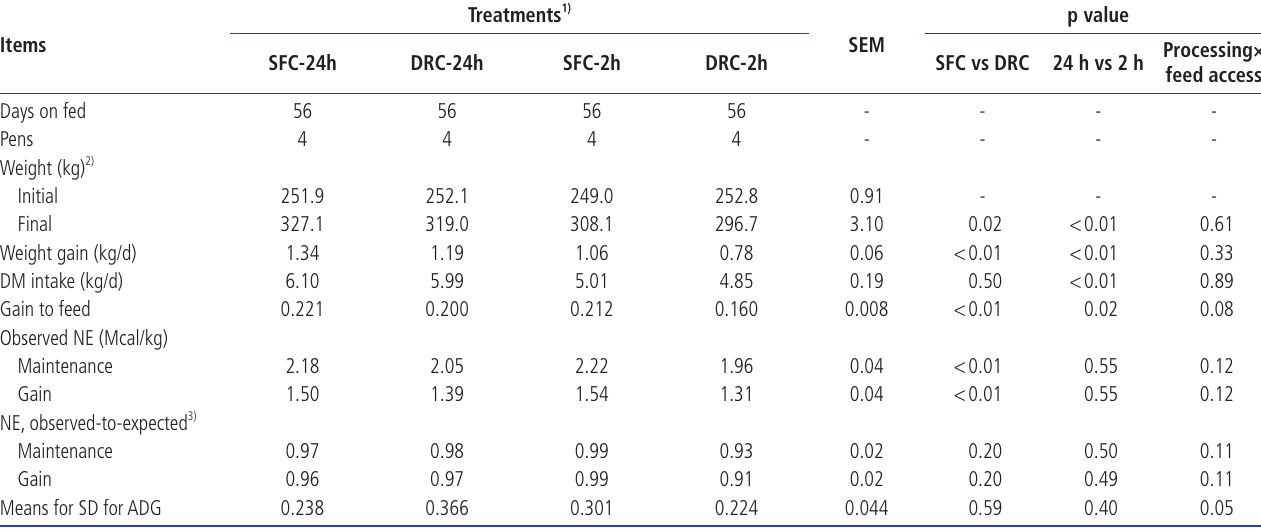
Table 2. Influence of corn processing and time period of feed access on growth performance and dietary energy of feedlot steers